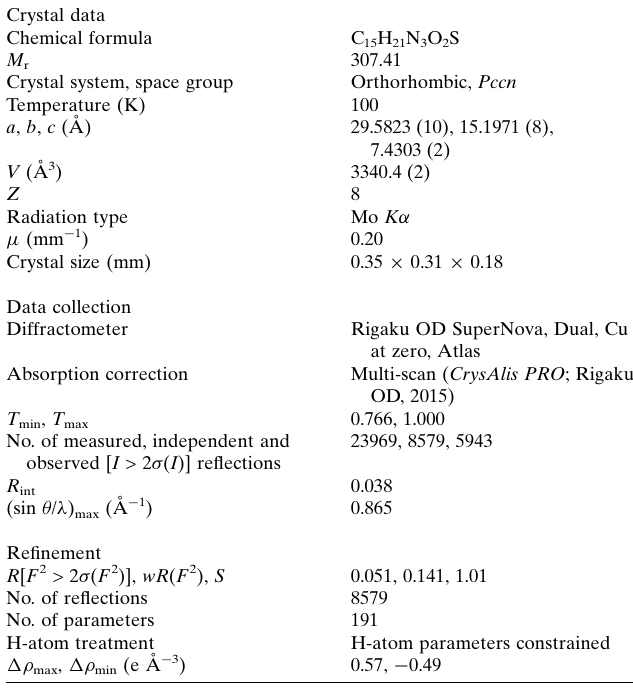
Table 2 Experimental details. Crystal data Chemical